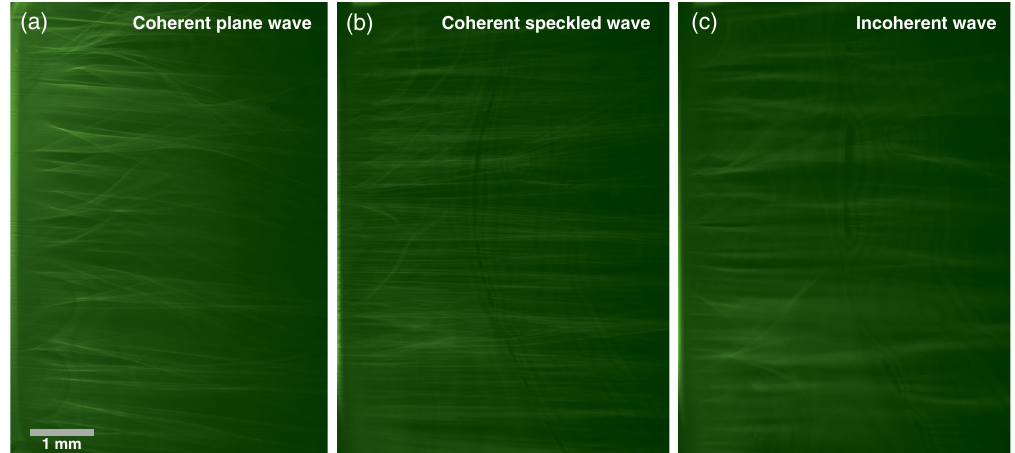
FIG. 2. Examples of branched flow patterns formed by (a) coherent plane wave, (b) coherent speckled beam generated by passing a coherent plane wave through a static diffuser, (c) partially-spatially-incoherent beam, generated by passing a coherent plane wave through the same diffuser while